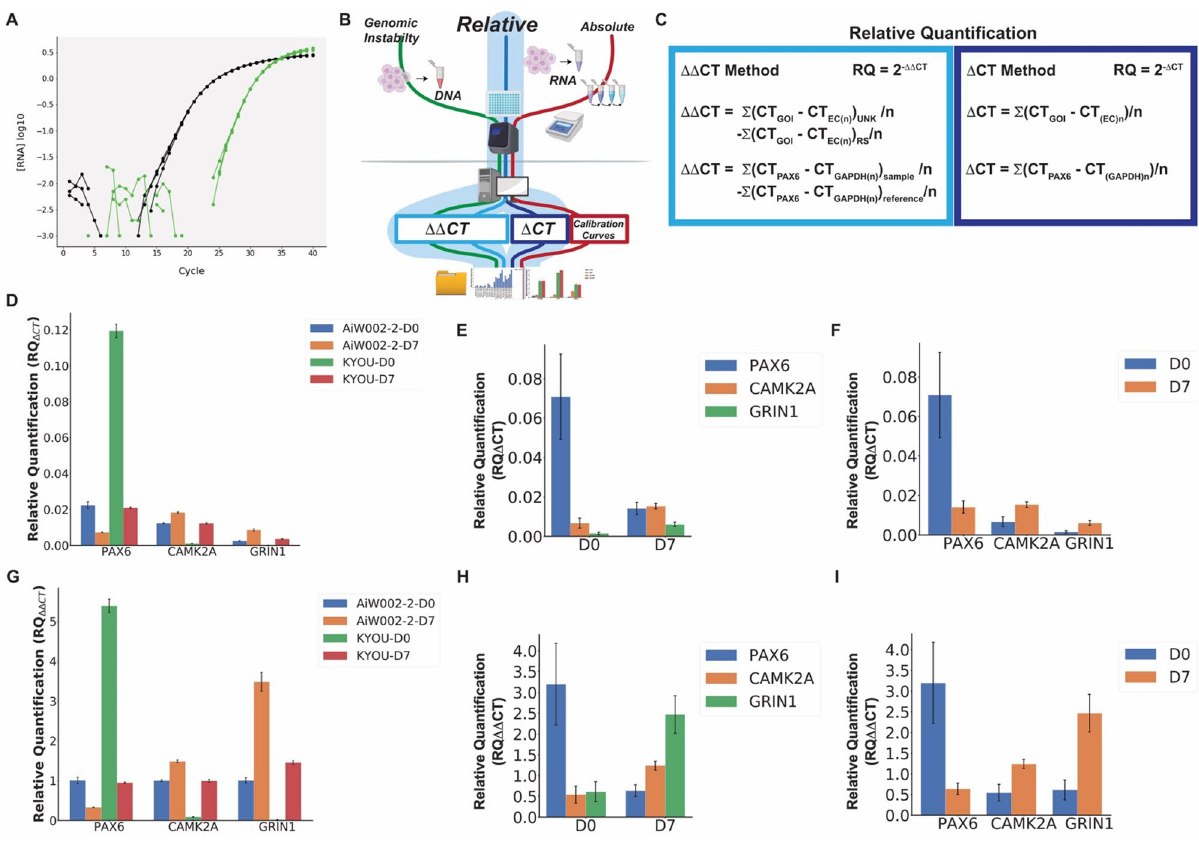
Figure 4. Auto-qPCR can process quantitative PCR data using two different relative models. Output of Auto-qPCR using the relative quantification with both the ∆CT and ∆∆CT models. ( A ) Amplification curves illustrating a difference of cycle threshold values (∆CT) between a gene of interest and an endogenous control. ( B ) Schematic of PCR workflow showing the two methods to calculate relative RNA quantity, ∆CT in dark blue and ∆∆CT in light blue. ( C ) Formula used to perform a qPCR using relative quantification models, according the ∆CT (right), or the ∆∆CT methods (left). ( D – F ) Bar charts showing the output of the delta-CT model (RQ ∆CT ). ( G – I ) Bar charts showing the output from the ΔΔ-CT model (RQ ∆∆CT ). ( D ) and ( G ) Mean normalized gene expression values from technical replicates for the genes PAX6 , CAMK2A and GRIN1 indicated on the x-axis for 2 cell lines at two stages of differentiation (D0: Neural progenitor cells, and D7: cortical neurons at 7 days of differentiation) as indicated. ( E , H ) Statistics output showing the mean gene expression from two cell lines at two stages of differentiation indicated, for the three genes indicated on the x-axis. ( F , I ) Statistics output showing the mean expression values for two cell lines at two time points on the x-axis and the three genes indicated. Differential expression between D0 and D7 is not significant ( PAX6 p = 0.40, CAMK2A p = 0.18, GRIN1 p = 0.16), t tests, n =